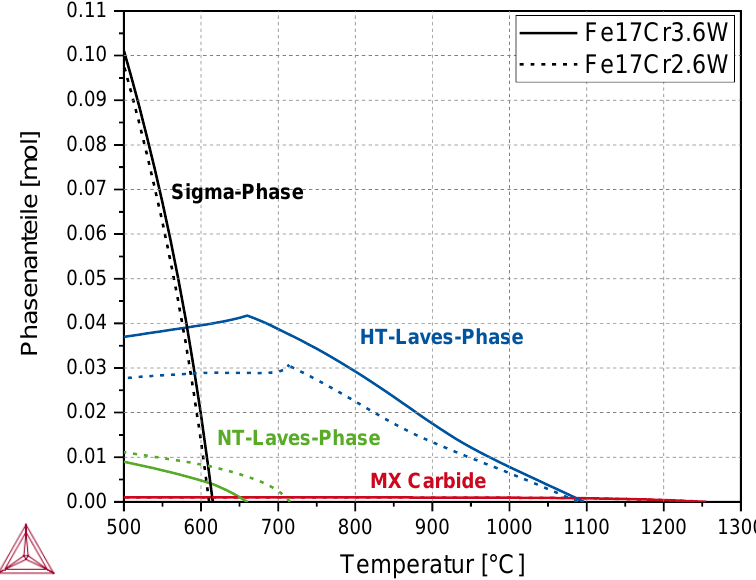
Figure 4. Results of thermodynamic equilibrium calculations of phase amount in tested alloys Fe17Cr with the tungsten content of 2.6 or 3.6 wt. %, respectively (ThermoCalc ® , database TCFE8).